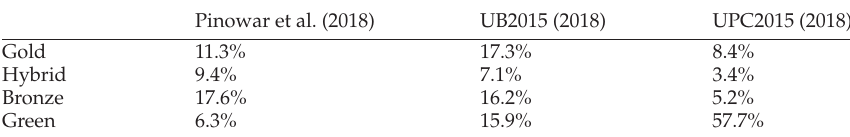
Table 4: Percentages of open access for articles published in 2015 from UB and UPC in comparison to the results published in the global study carried out by Pinowar et al.